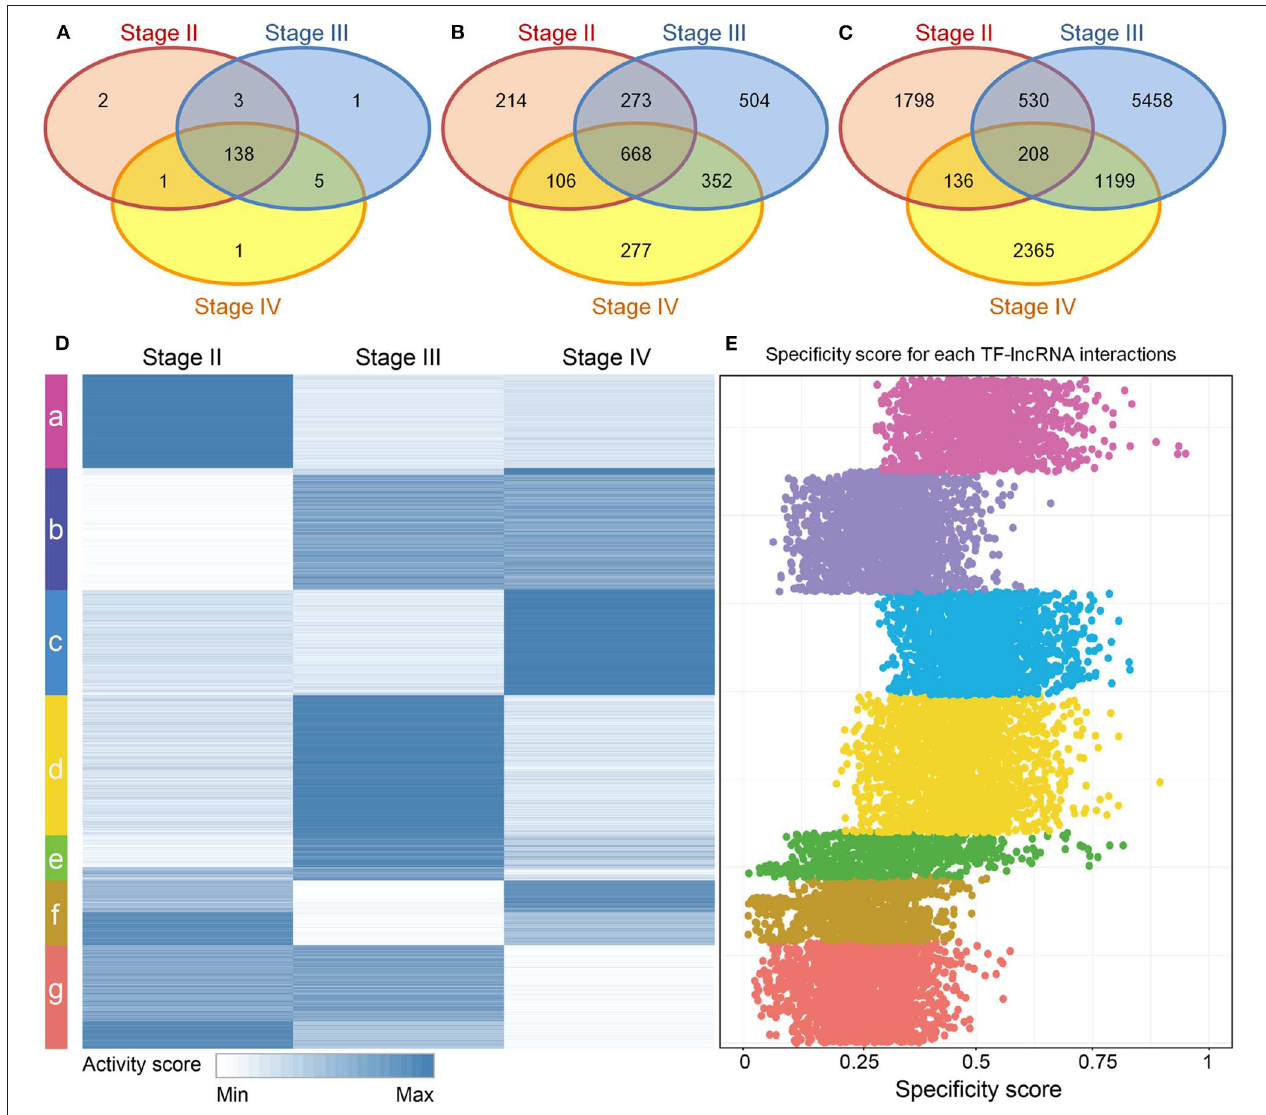
FIGURE 3 | Dynamic TF-lncRNA interactions across the progression of OC. (A–C) Venn diagrams showing the overlaps of TFs, lncRNAs and their regulation in different stages. TFs in different stages of OC regulate different target lncRNAs. (D) The activity profile for TF-lncRNA relationships across different stages of OC. The co-expression coefficients for TF-lncRNA pairs in each stage of OC were used as activity scores. Clustering analysis revealed that different groups of TF-lncRNA relationships were apparently activated in one or more stages of OC. (E) The corresponding specificity scores were plotted. The groups a, c, d, and e have higher specificity scores than other groups, indicating these groups are stage